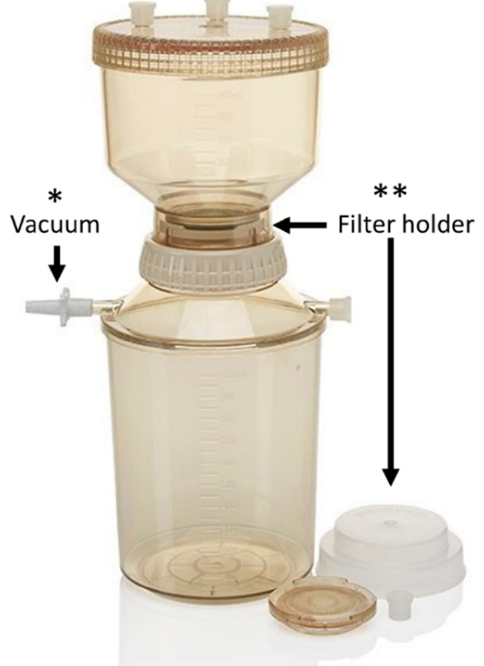
Figure 2. Nalgene TM reusable unit for 250 mL water filtration. Details of vacuum nozzle (*) and filter holder (**).